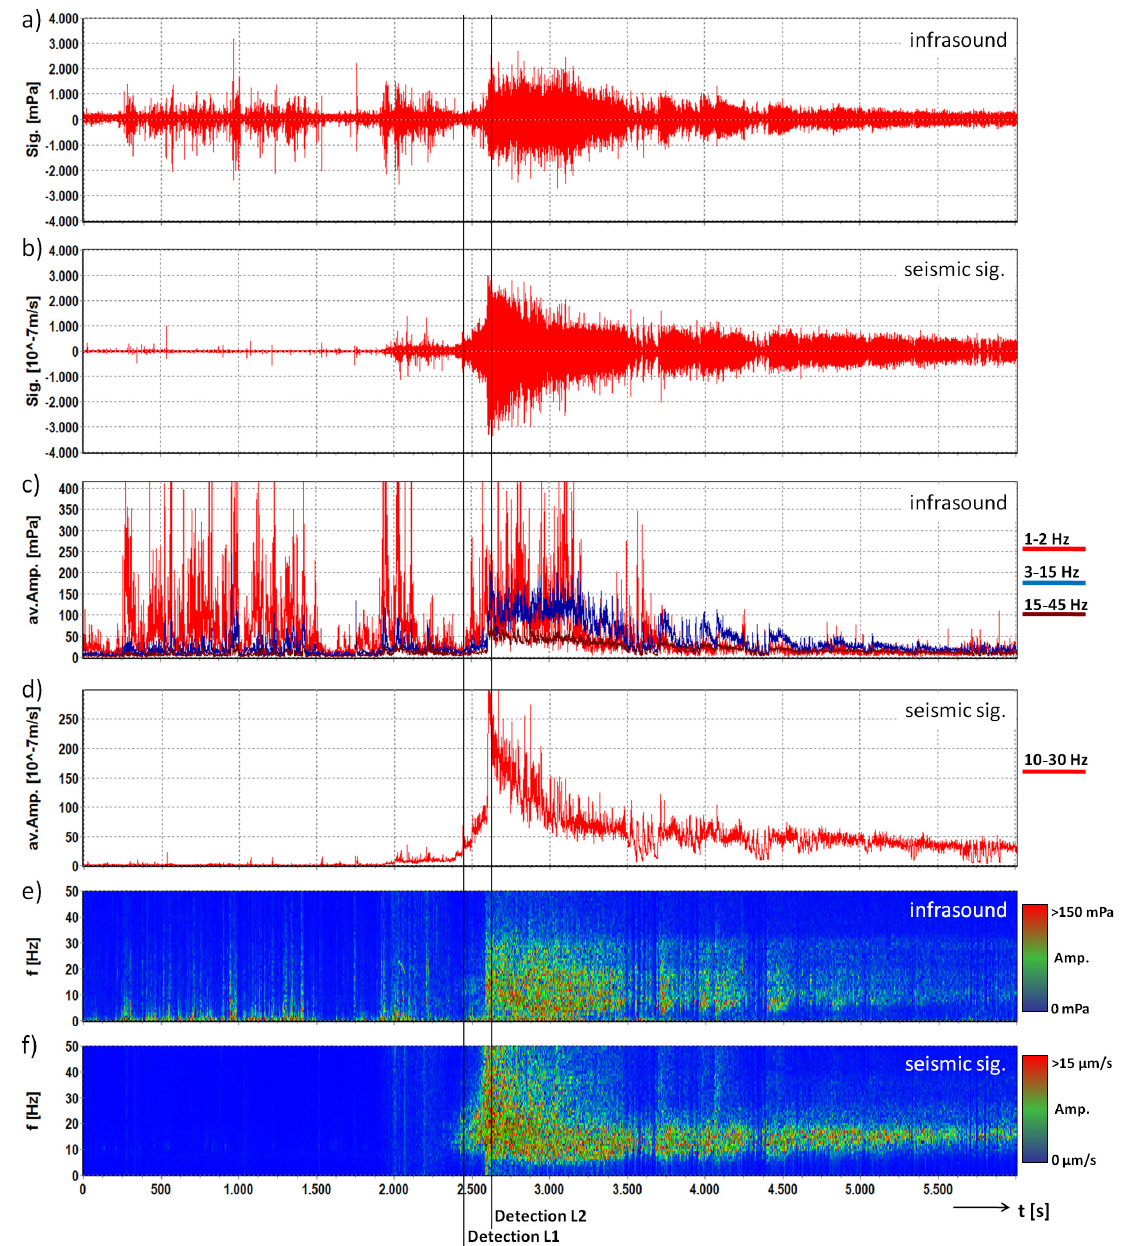
Figure 7. Infrasound and seismic data of the debris flow monitored at the Illgraben test site on 22 July 2015 at Station 2. Signals are represented with a common base of time. ( a ) infrasound time series; ( b ) seismogram; ( c ) average amplitude of the three frequency bands of the infrasound signal; ( d ) average amplitude of the frequency band of the seismic signal; ( e ) running spectrum of the infrasound signal; ( f ) running spectrum of the seismic signal; lines: time of first detection for Levels 1 and